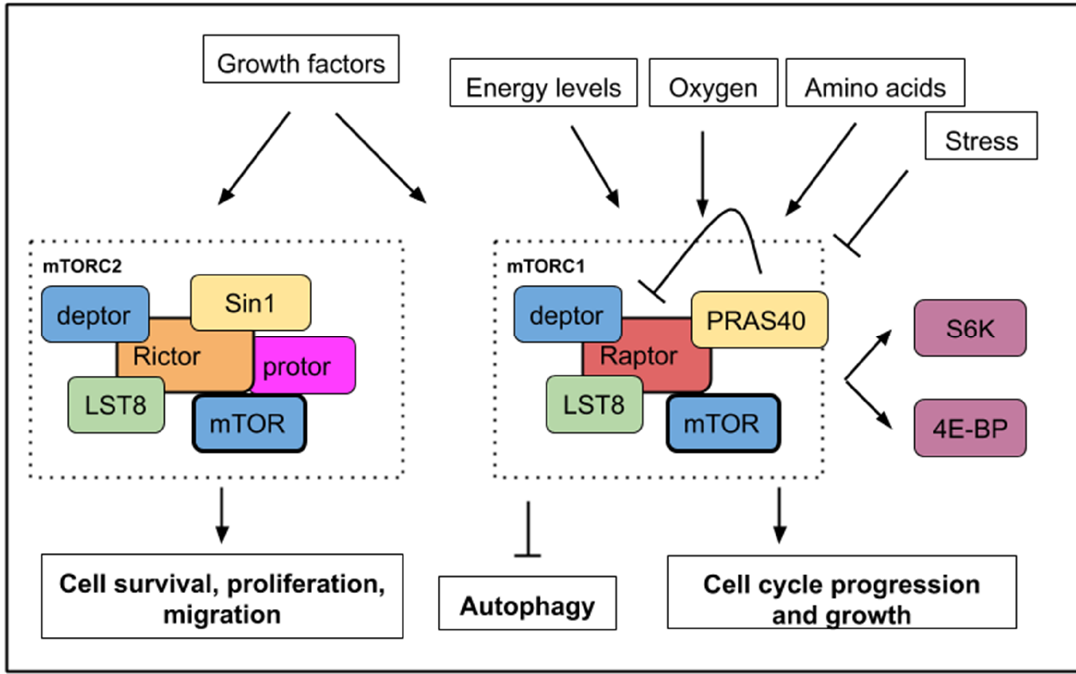
Figure 1. A simplified mTOR (mechanistic/mammalian target of rapamycin) pathway with upstream signals, which activate or inhibit mTORC1 or mTORC2 activities. mTORC1 activity is sensitive to growth factors, energy levels, oxygen, amino acids, and stress while mTORC2 activity responds to growth factors only. Below, the main cellular processes, which are affected by mTOR activity. mTORC1 activity leads to cell growth, cell cycle progression with an increased phosphorylation of S6K1/2 (S6 kinase 1/2) and 4E-BP (4E binding protein). mTORC1 activity inhibits autophagy. mTORC2 activity controls cell survival, proliferation, and migration.